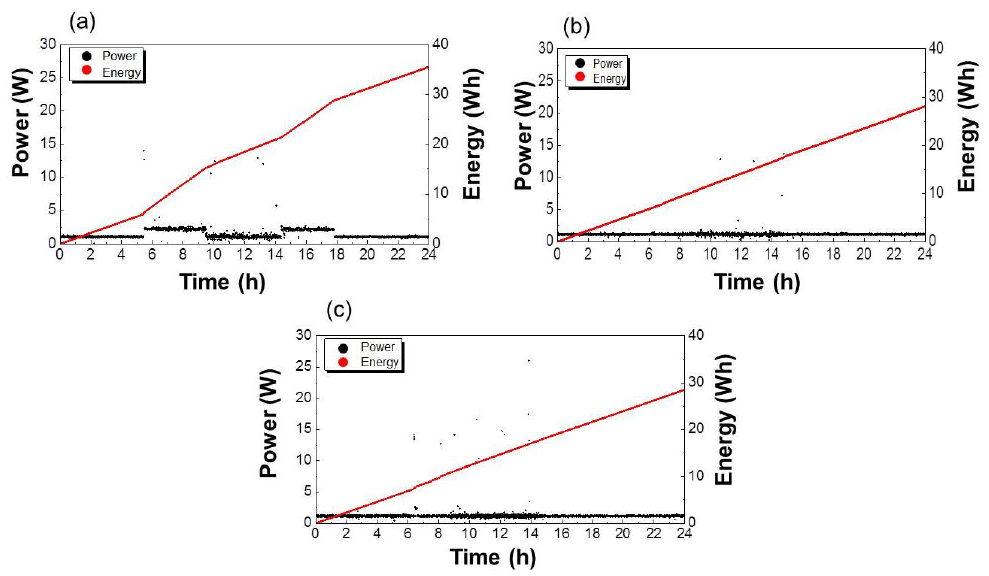
Figure 5. Power and energy consumption of the tracking system on ( a ) a sunny day, ( b ) a cloudy day, ( c ) a rainy day.